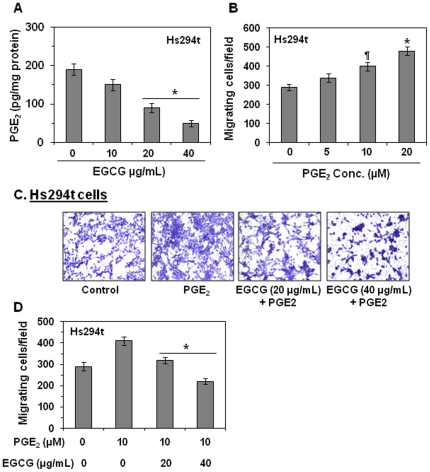
EGCG inhibits PGE2-induced melanoma cell migration.(A) Dose-dependent effect of EGCG on the levels of PGE2 in melanoma Hs294t cells. The levels of PGE2 are expressed in terms of pg/mg protein± SD, n = 3 independent experiments. Significant inhibition by EGCG versus non-EGCG-treated controls, *
P<0.001. (B) Treatment of Hs294t cells with PGE2 enhances cell migration in a concentration-dependent manner. Significant difference versus control, ¶
P<0.05, *
P<0.001. (C) Treatment of cells with EGCG (20 and 40 µg/mL) inhibits PGE2-enhanced cell migration capacity of Hs294t cells. Representative photomicrographs of cell migration were presented from three independent experiments. (D) The data on cell migration are summarized as a mean number of migratory cells ± SD/microscopic field. Significant inhibition versus PGE2 alone: *
P<0.001. Cell invasion assays under each experiment were repeated three times and in each case the migrating cells were counted and the results are expressed as a mean number of migratory cells ±SD/microscopic field.